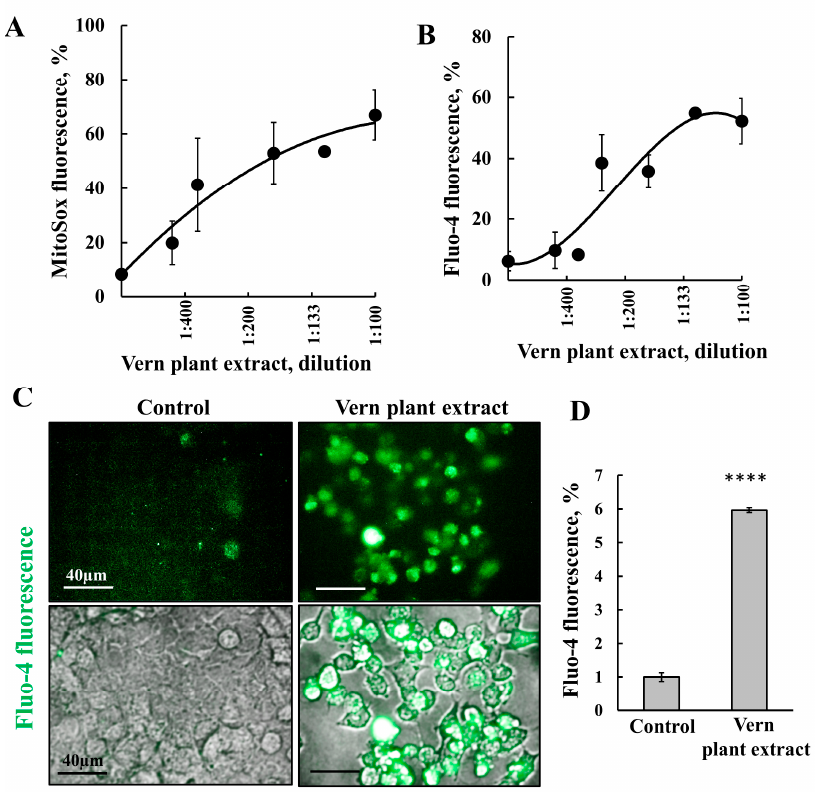
Figure 3. Vern plant extract induced increased intracellular Ca 2+ and ROS production . SH-SY5Y cells were incubated for 24 h with the indicated dilutions of Vern plant extract and analyzed for ROS production using MitoSox Red reagent and FACS analysis ( A ), and for intracellular [Ca 2+ ]i, using the calcium indicator Fluo-4 reagent and FACS analysis [46] ( B ), or for Vern plant extract treatment at 1:333 dilution is visualized using Operetta imaging ( C ), and quantified ( D ) **** p <